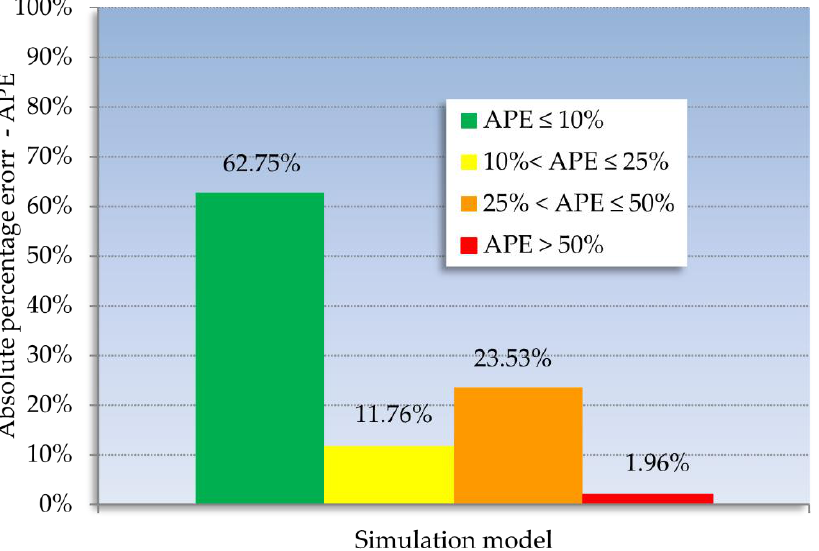
Figure 8. Absolute errors of predicted values of the simulation model for the case of full concrete plant availability.